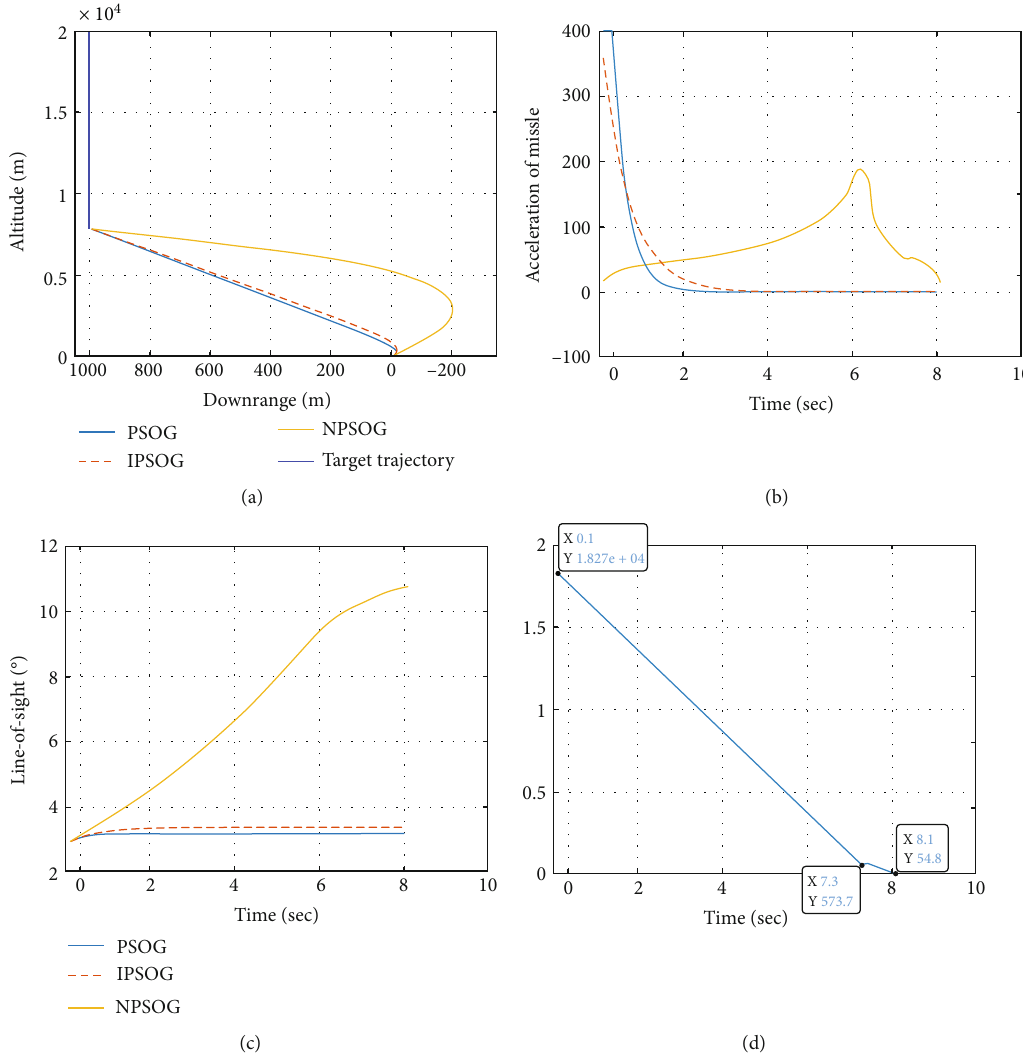
Figure 4: Simulation results of intercepting nonmaneuvering hypersonic